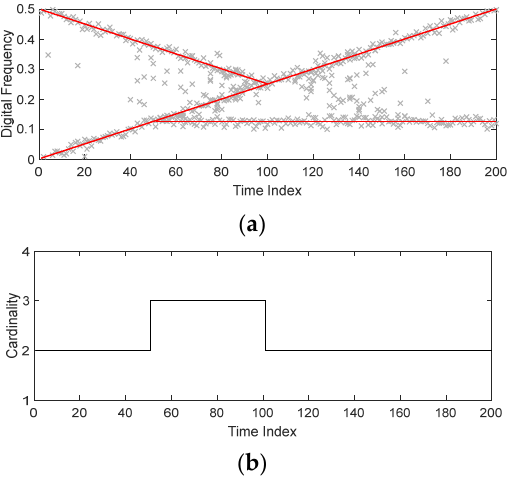
Figure 3. True trajectory (case 2): ( a ) Measurement and clutter; ( b ) Cardinality.